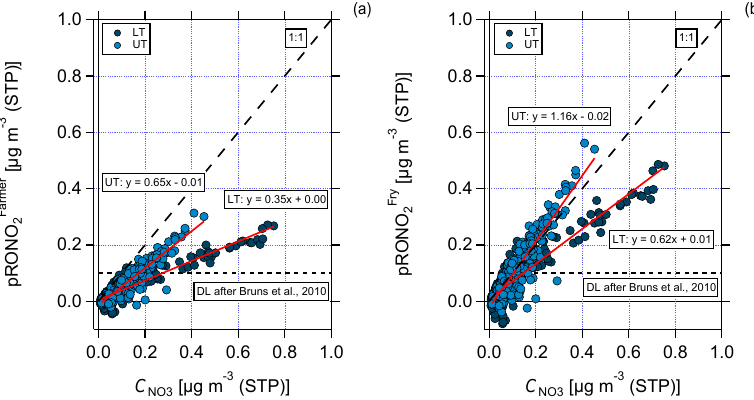
Figure 12. Scatter plots of measured nitrate mass concentration against organic nitrate mass concentration calculated according to (a) Farmer et al. (2010) and Kiendler-Scharr et al. (2016) and (b) Fry et al. (2013) for the lower troposphere (dark blue, LT) and upper troposphere (light blue, UT), respectively. Data are averaged over 2min. The horizontal dashed line shows the conservative detection limit of 0.1µgm − 3 according to Bruns et al. (2010). The 1:1 line indicates that all particulate nitrate is present as organic nitrate. Also shown are the two fit functions (red) for UT and LT in both plots,